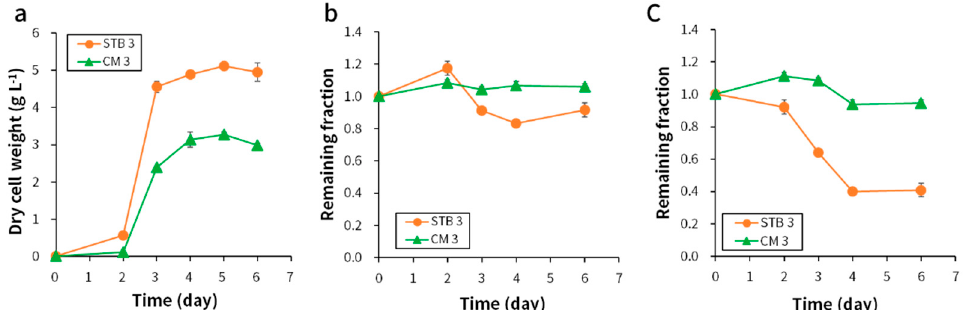
Figure 2. Nutrient consumption throughout the cultivation period depending on glucose concen- tration: ( a ) COD and ( b ) T-N. The amount of consumed nutrients was calculated from the average values regarding the beginning and the end of the cultivation.